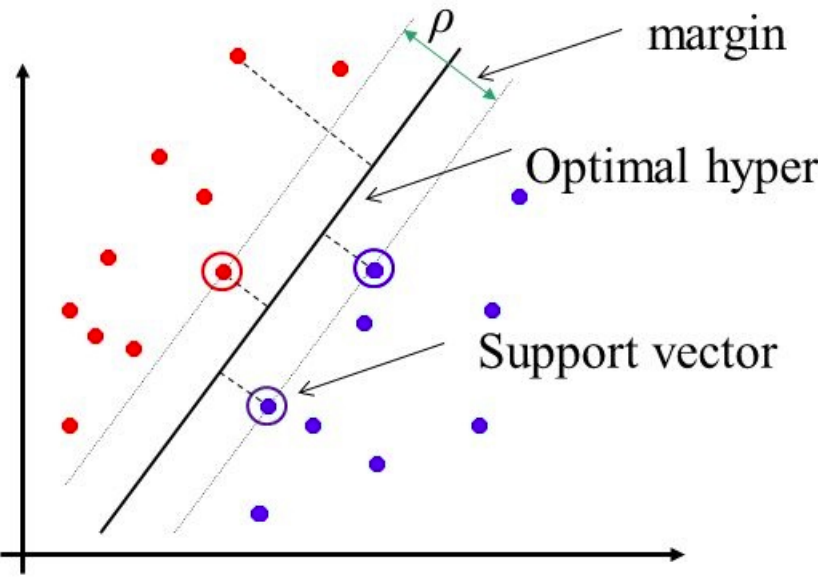
Figure 3. An Illustration of a hyperplane and support